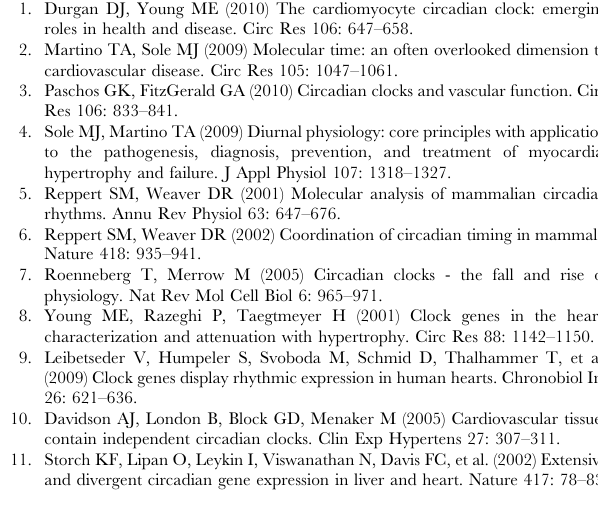
Figure S1 Log10 transformed data, Per2 and Tcap mRNA, illustrating the magnitude of the Clock genotype effect. The Per2 mRNA profile (left) in Clock D 19/ D 19 hearts is severely blunted in amplitude, consistent with Per2 being a target gene. It is still periodic, but phase is advanced and expression levels and amplitude are greatly reduced. For Tcap in Clock D 19/ D 19 hearts (right), again mRNA expression levels and amplitude are severely blunted, consistent with it being a target gene. Also, in Clock D 19/ D 19 hearts, gene expression is barely periodic, which makes estimating phase and amplitude challenging. Table S1 94 rhythmic cardiac transcripts (p , 0.001) with period 23–25 h and phase 16–20 h as determined by CircaDB. Table S2 Heart-enriched circadian genes selected using the BioGPS website, GeneAtlas MOE430